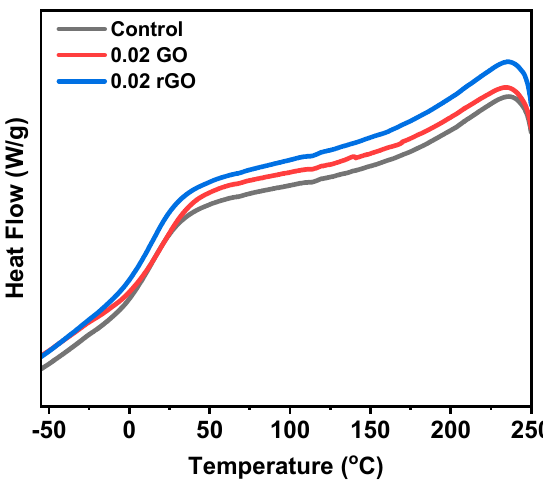
Figure 9. DSC for the control, 0.02 wt.% GO and 0.02 wt.% rGO.